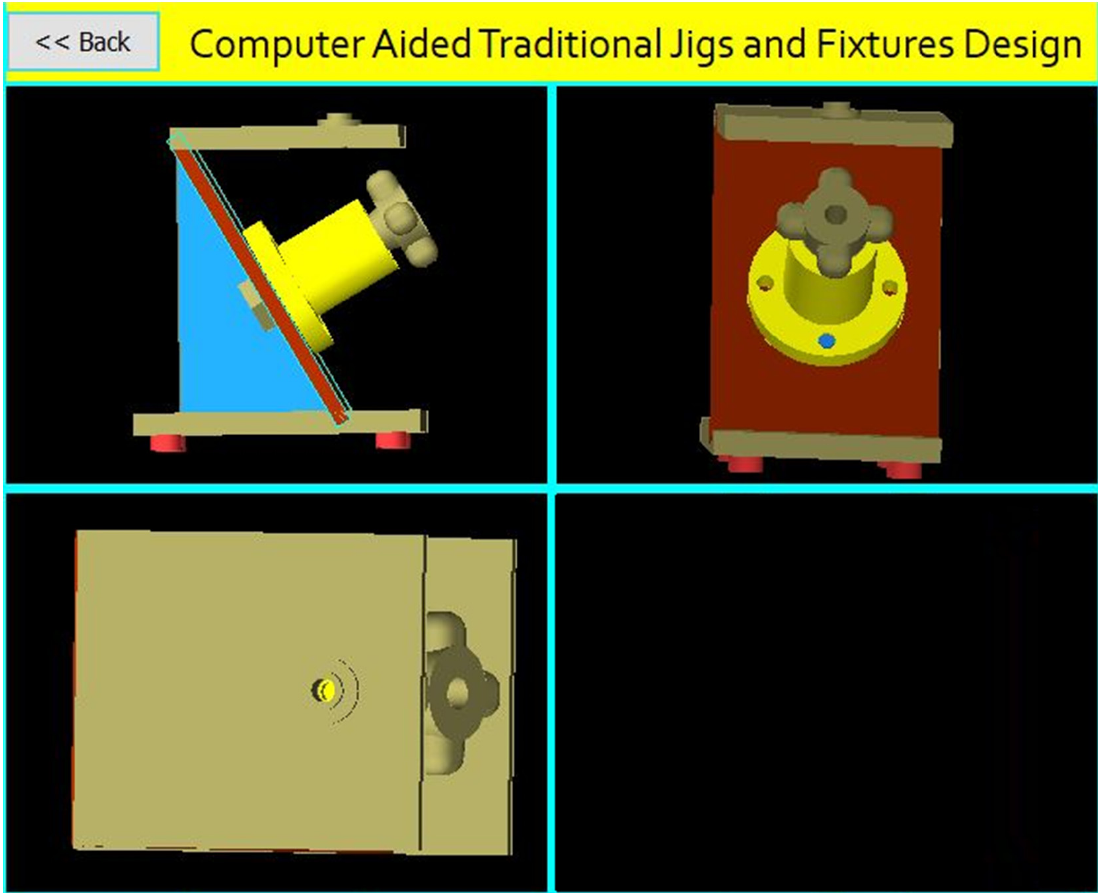
Figure 33. The jig